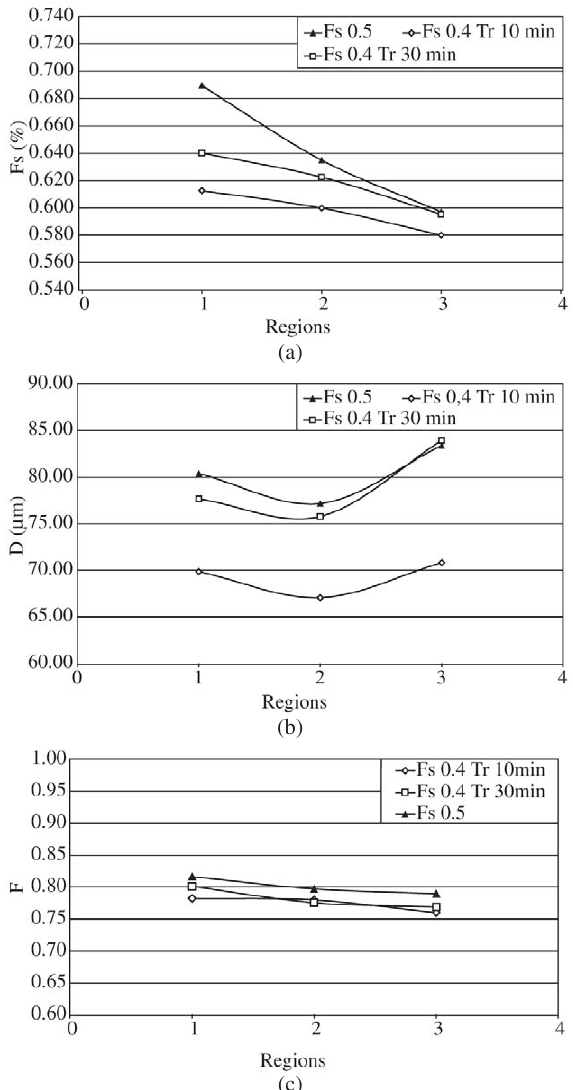
Figure 9. Quantitative metallographic features of the thixoformed cups and their spatial distribution within the part: a) solid fraction distribution; b) average particle size distribution; c) shape factor. The solid fractions of the samples were 0.4 and 0.5 and the soak- ing times 10 and 30